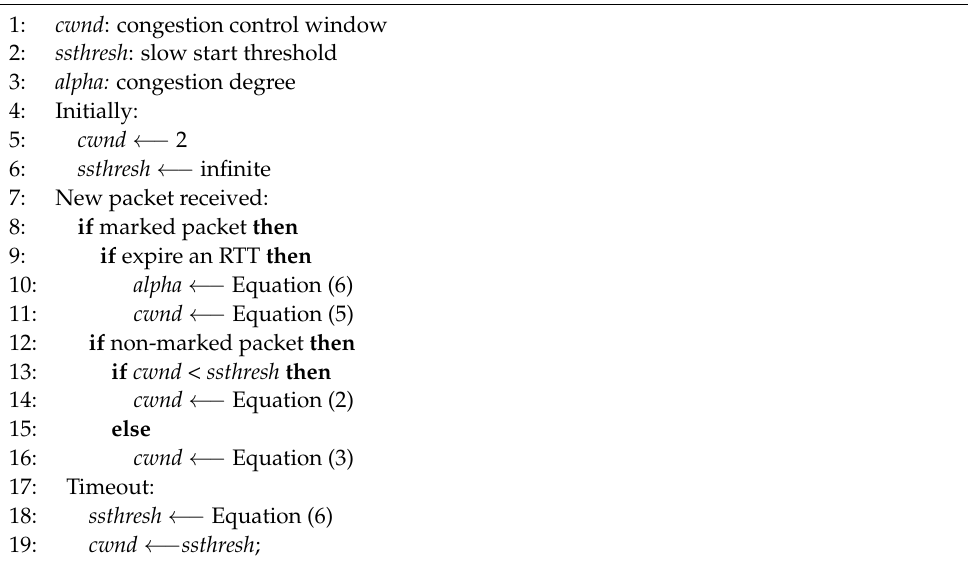
Algorithm 2 Congestion Adjustment